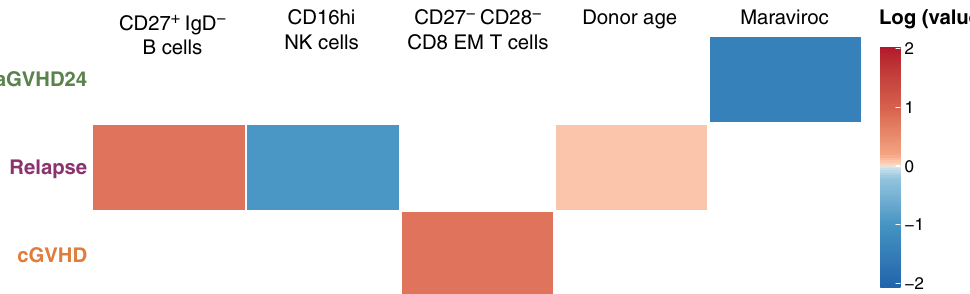
Figure 2. Selected variables and their coefficients (the logarithm of the subdistribution hazard ratio). Positive coefficients (red) are associated with increased event probabilities; negative coefficients (blue) with decreased probabilities.